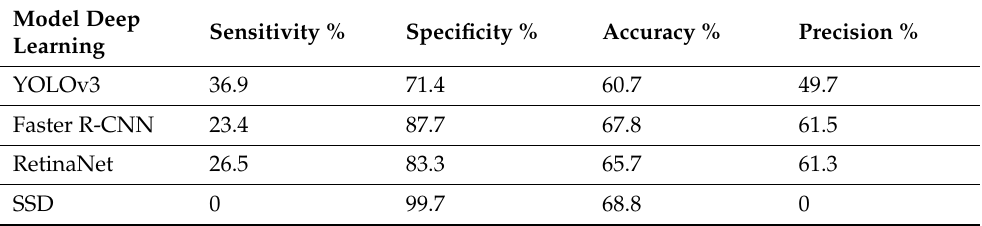
Table 2. Model evaluation: results of VNC vs. NSC